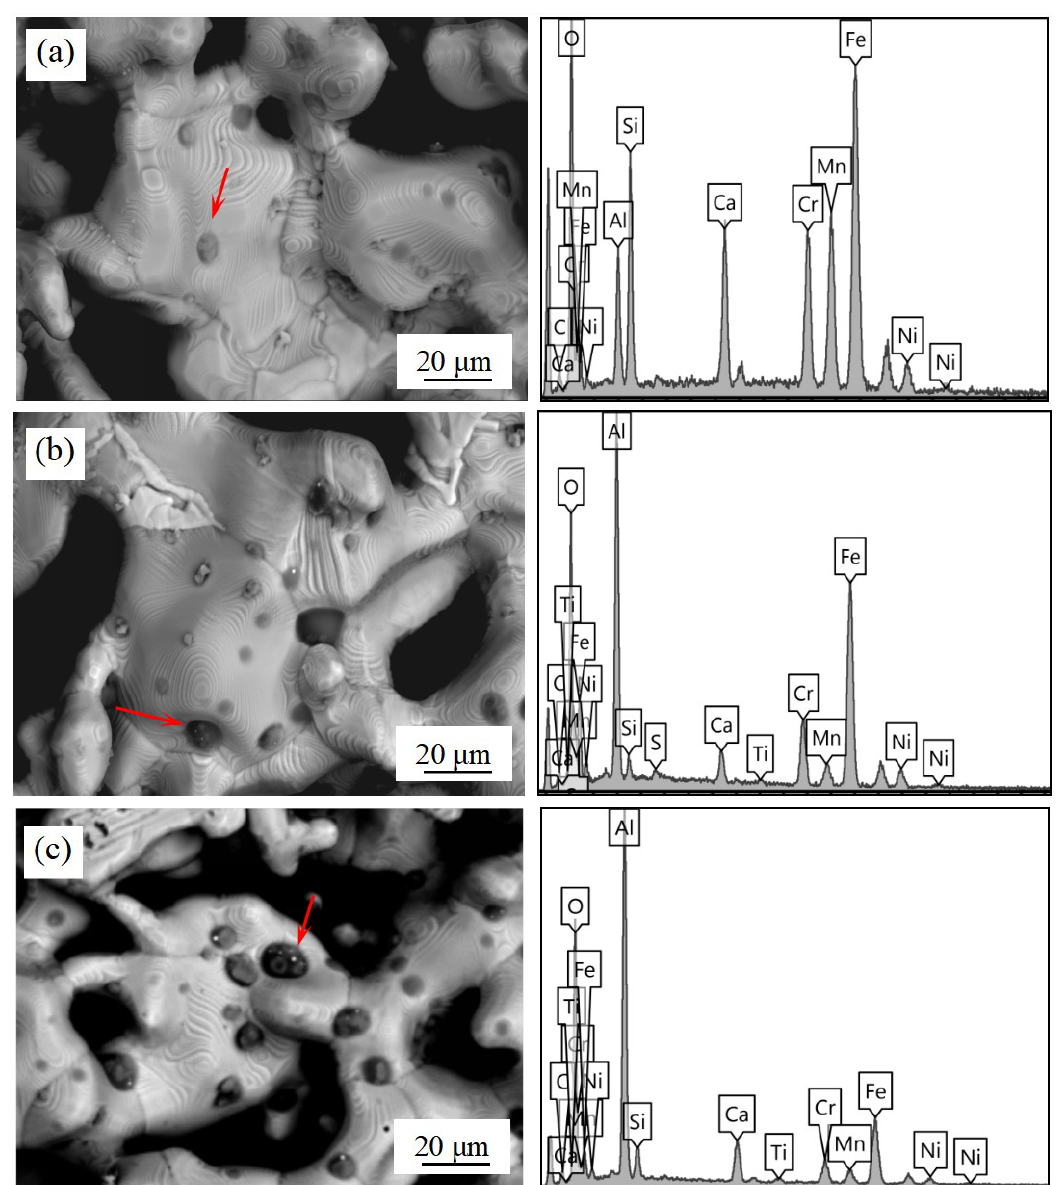
Figure 16. Back-scattered electronic image and composition analysis of particles at 10 −4 atm and 1200 °C; ( a ) 60 min; ( b ) 120 min; and ( c ) 180 min; the energy spectrum analysis is on the right side of the back-scattered electronic image.